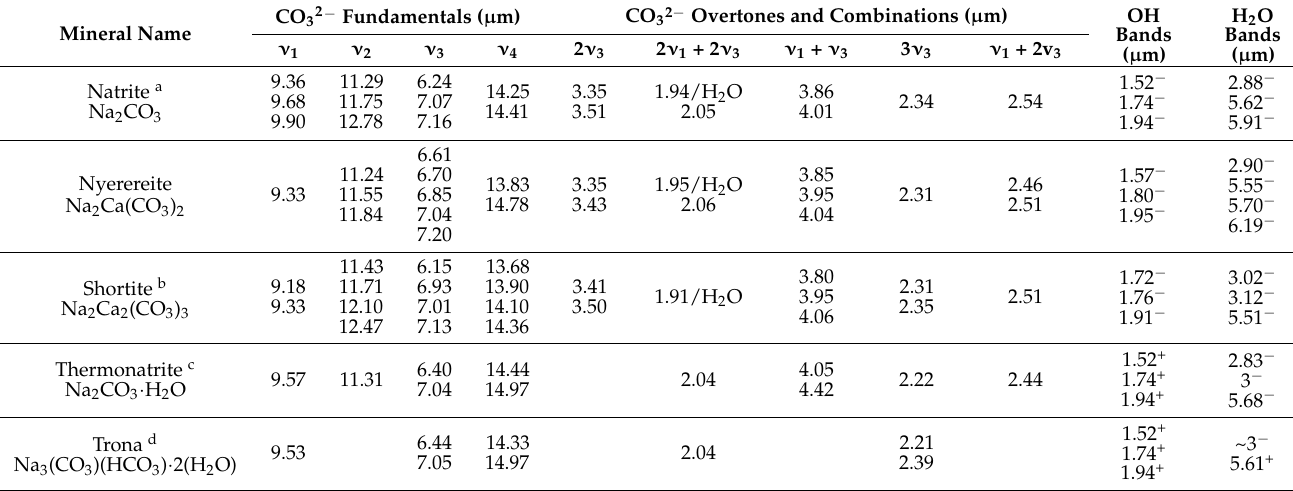
Table 2. CO 32 − , H 2 O, and OH band positions in the reflectance spectra collected at 298K for all the investigated samples. Absorption band assignments were made following De Angelis et al. [18] (a,c), Frost and Palmer [49], Clark [50], Zhu et al. [51], Adler and Kerr [66] (b), and Harner and Gilmore [40] (d). The symbols + and – indicate bands assigned to structural water (H 2 O + ) and hydroscopic water (H 2 O − ); see text for